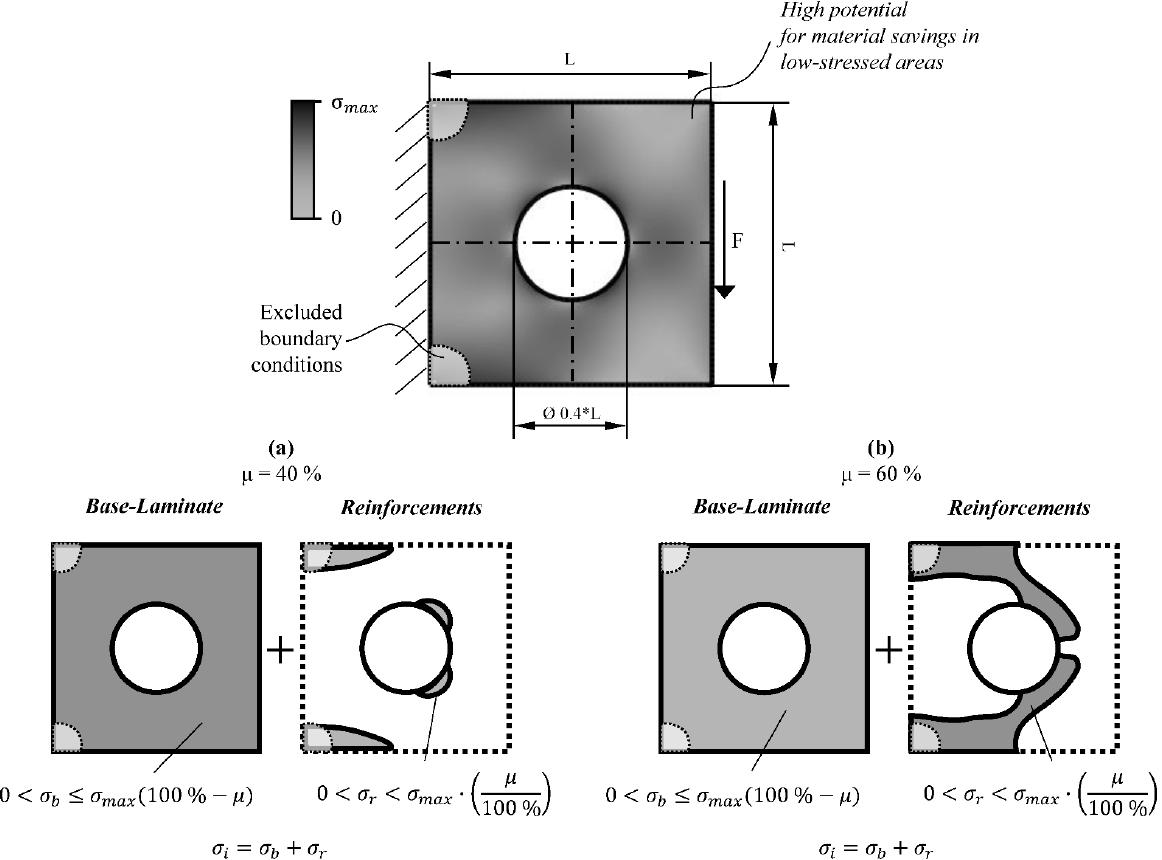
Figure 4. Schematic illustration of the split into base-laminate and reinforcement area for stress thresholds µ = 40% ( a ) and µ = 60% ( b ).